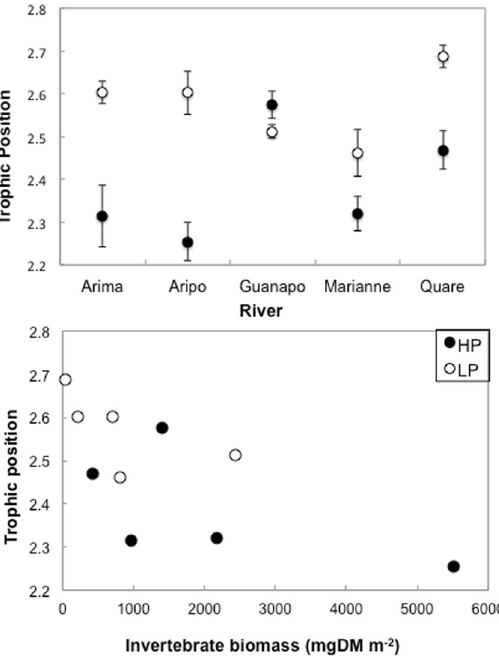
Figure 4. Top: Guppy trophic position across HP and LP sites in the five studied streams. Bottom: Relationship between guppy trophic position and invertebrate biomass in the five studied streams. HP guppies: filled symbols; LP guppies: open symbols. Values are averages of raw data. Error bars are ± 1 standard